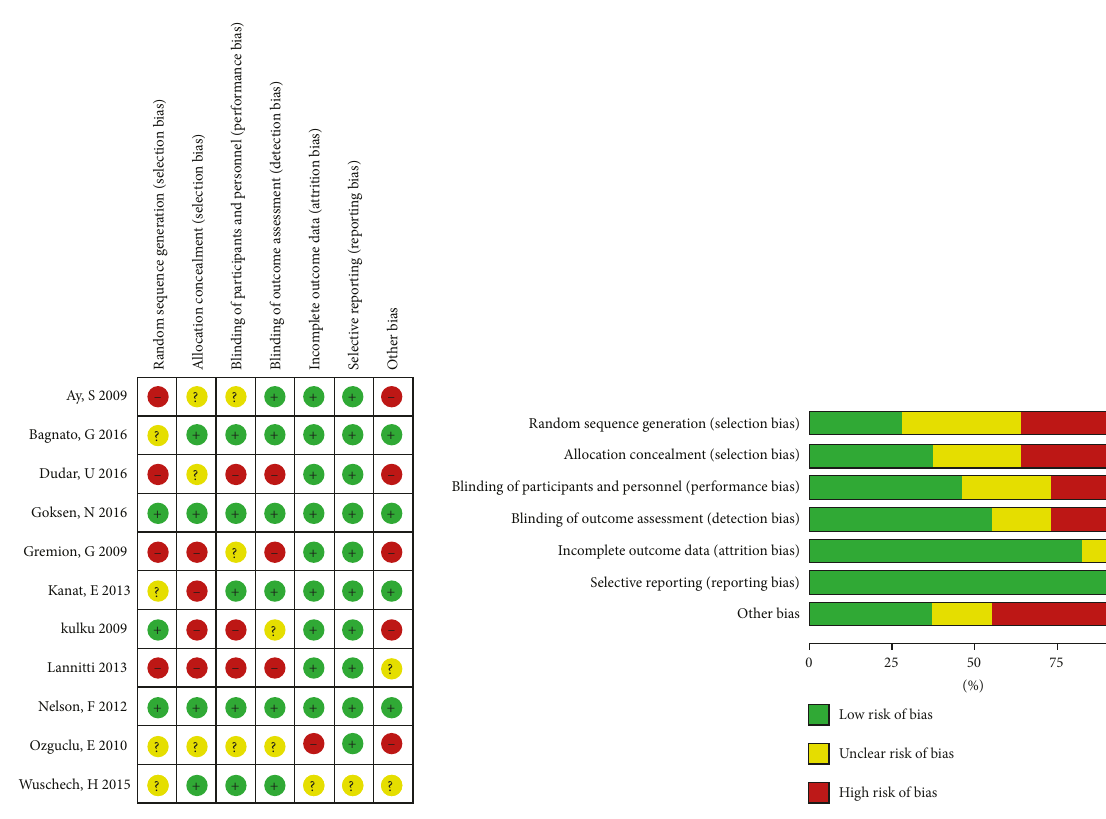
Figure 1: Risk of bias summary of records in this